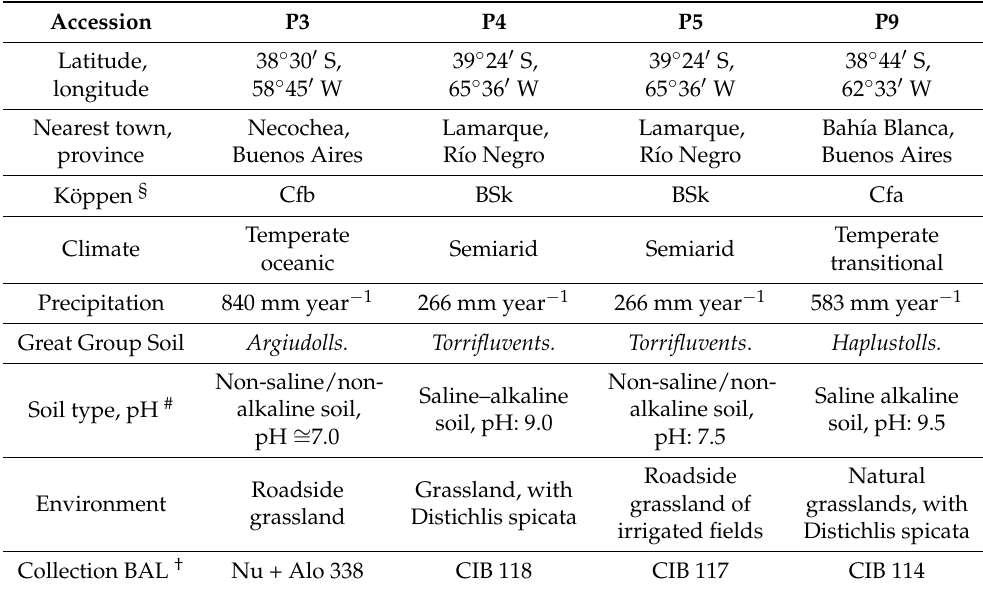
Table 2. Tall wheatgrass accessions. Collection data from Active Germplasm Bank of Estaci ó n Experimental Agropecuaria Balcarce of the INTA, Argentina